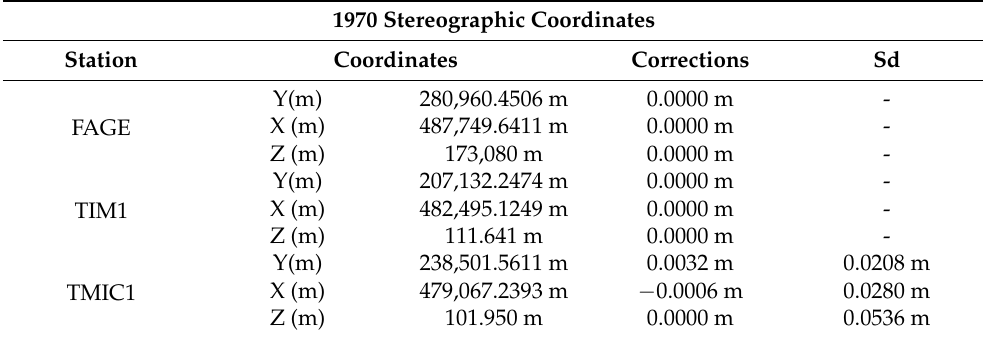
Table 9. Coordinate inventory of new points in Stereographic System 1970, resulting from transfor- mations for STATIC measurements, Topolov ă ¸tu